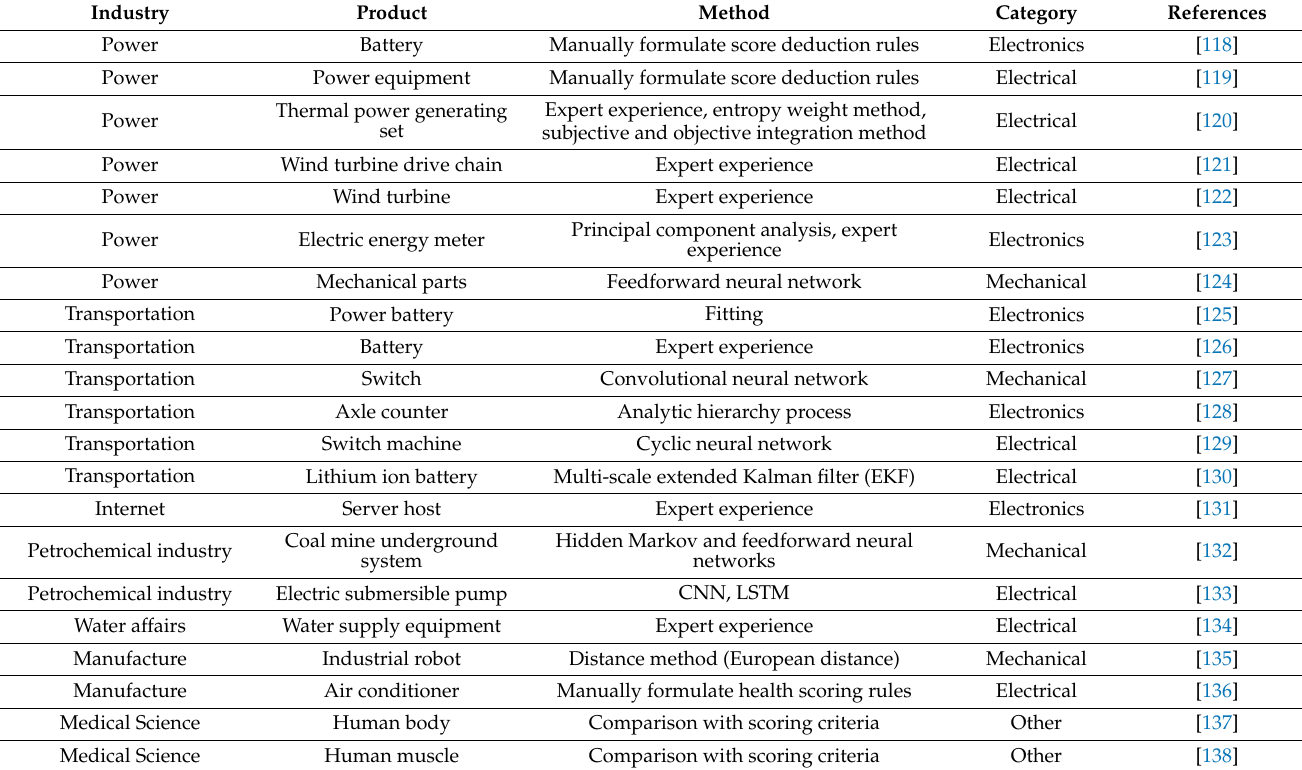
Table 9. Health assessment in various industries.